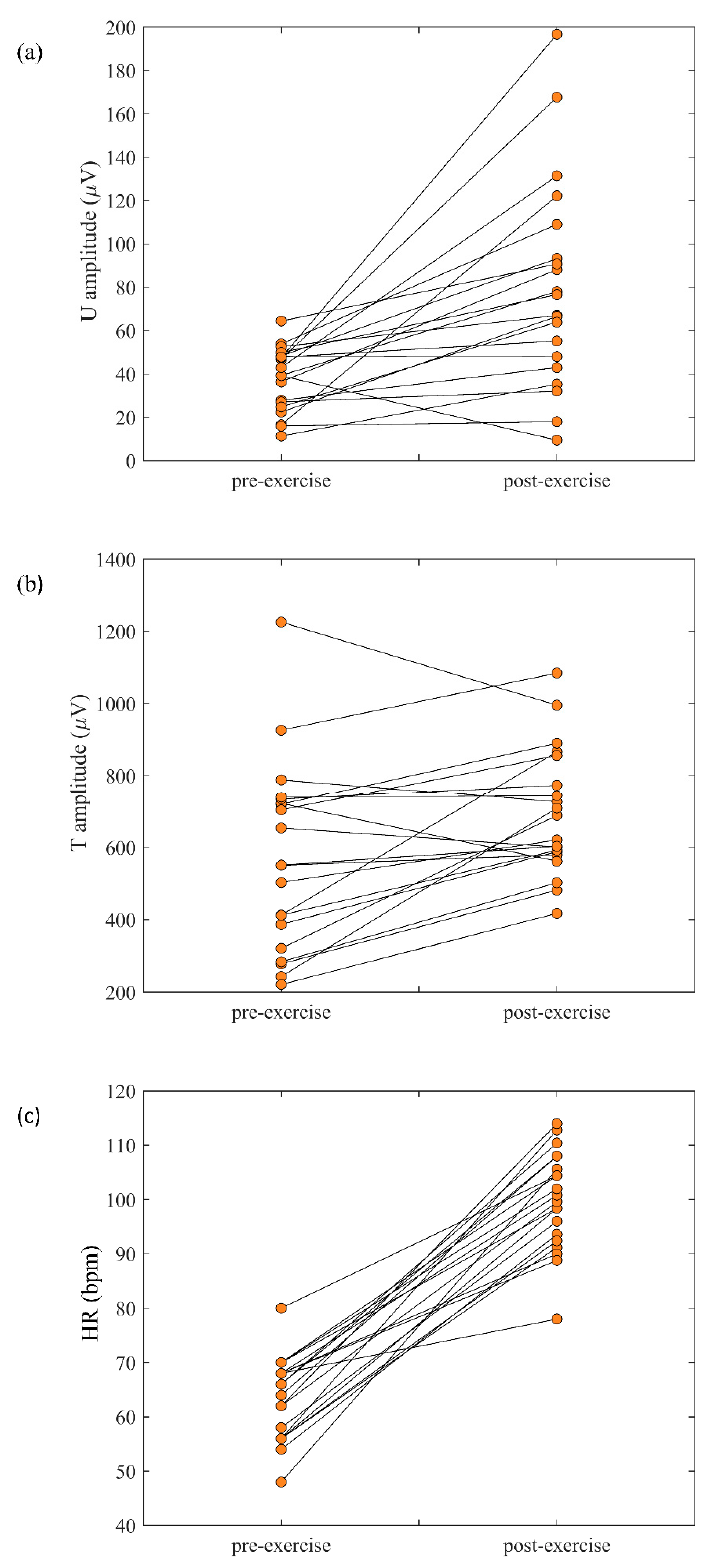
Figure 5. Paired relationship for ( a ) U wave amplitudes, ( b ) T wave amplitudes, and ( c ) heart rates (HR) for 20 subjects during the pre- and post-exercise recordings.